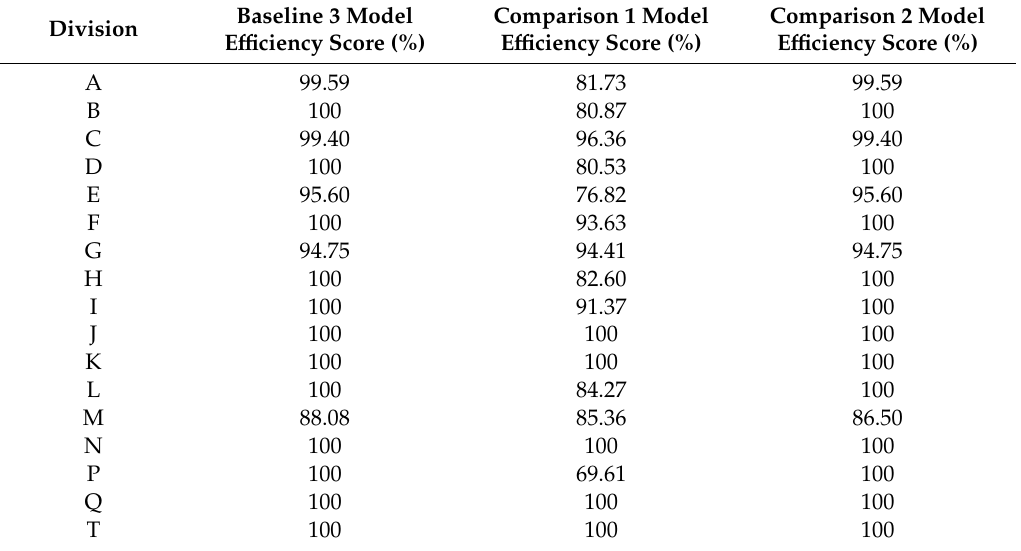
Table 2. DEA e ffi ciency scores resulting from Baseline 3, Comparison 1, and Comparison 2 DEA